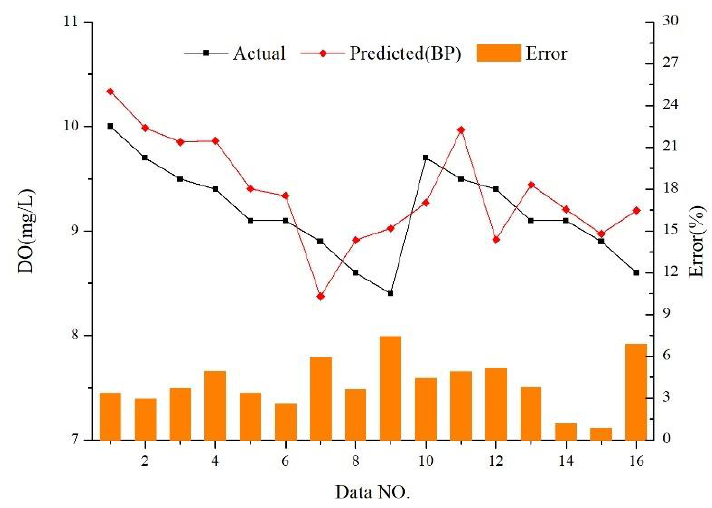
Figure 10. The predicted BP value and its error percentage.